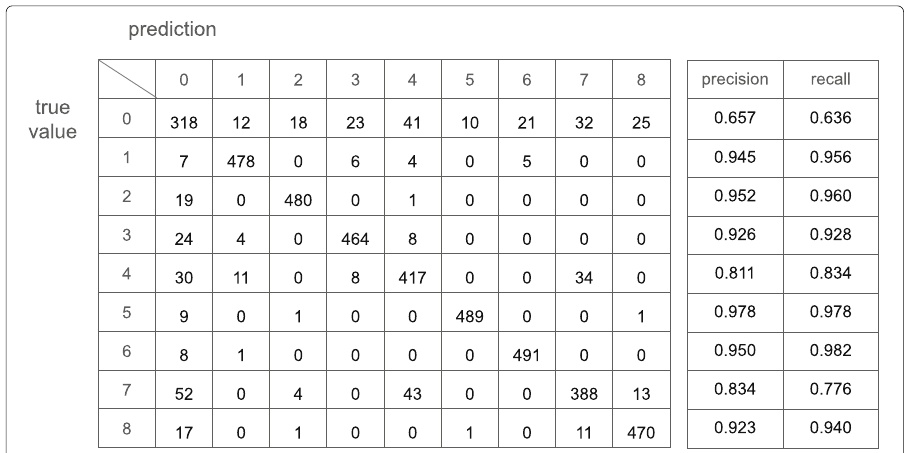
Fig. 13 The confusion matrix is from GAF-CNN without using pooling layers with opening, high, low, and closing prices (OHLC) feature set. The accuracy is 88.78% on